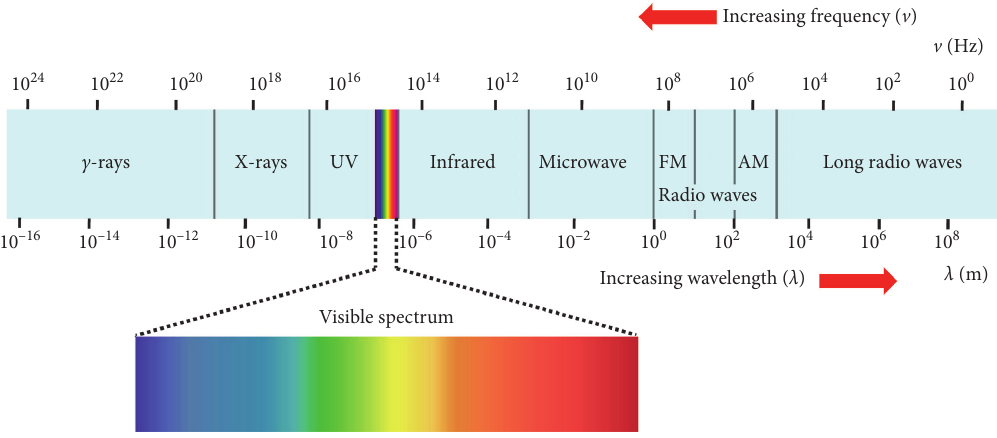
Figure 1: The solar electromagnetic